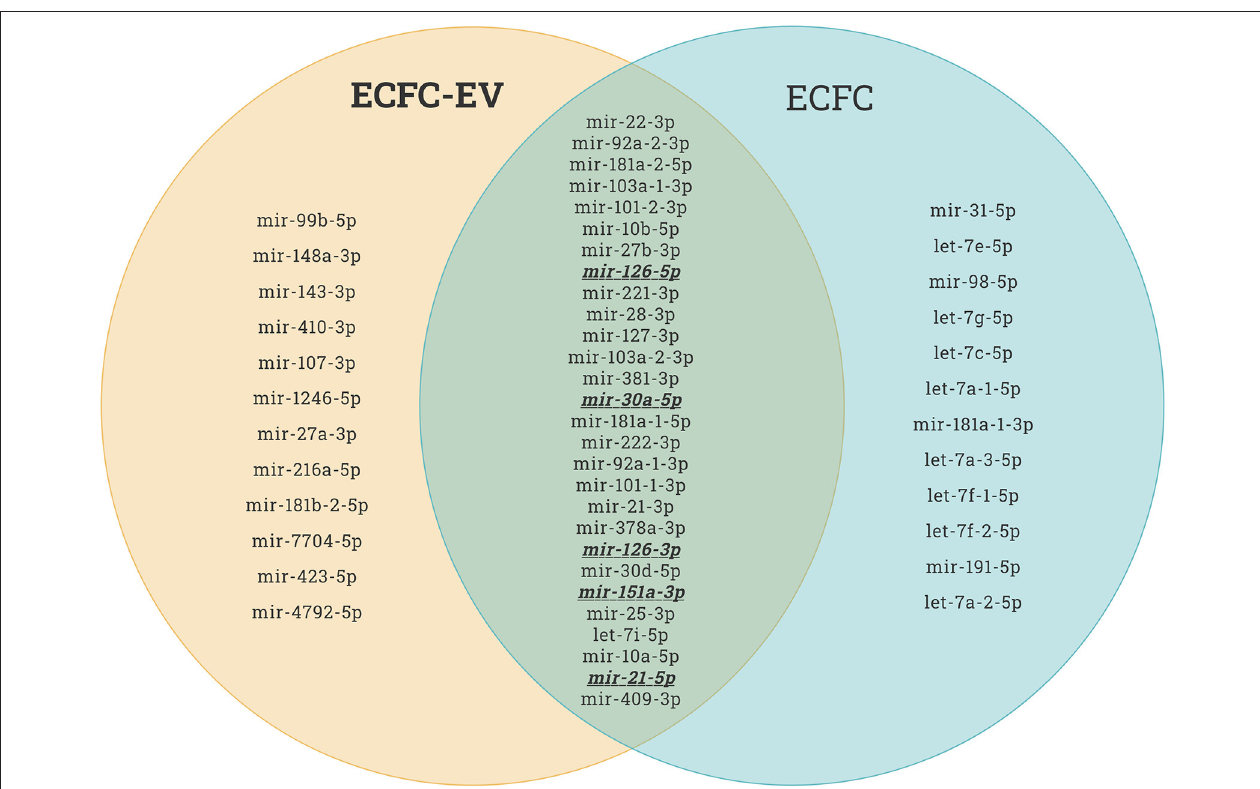
FIGURE 3 | Endothelial colony forming cell (ECFC)-derived microRNAs (miRs) vs. ECFC-extracellular vesicle (EV)-derived miRs. As shown in the Venn diagram, the majority of the top upregulated human miRs of both ECFC-derived and ECFC-EVs-derived miRs comprise similar miRs. This provides evidence that EPCs work via paracrine factors in organ regeneration. This miR sequence data was generated from PMID: